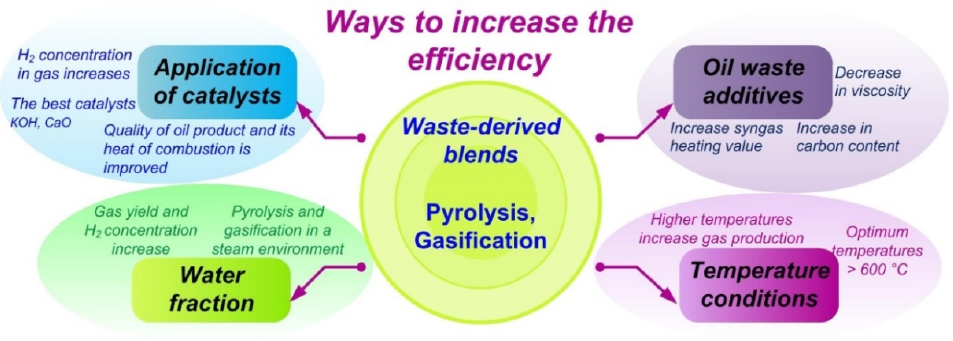
Figure 5. Features of pyrolysis and gasification of fuel slurries and blends.